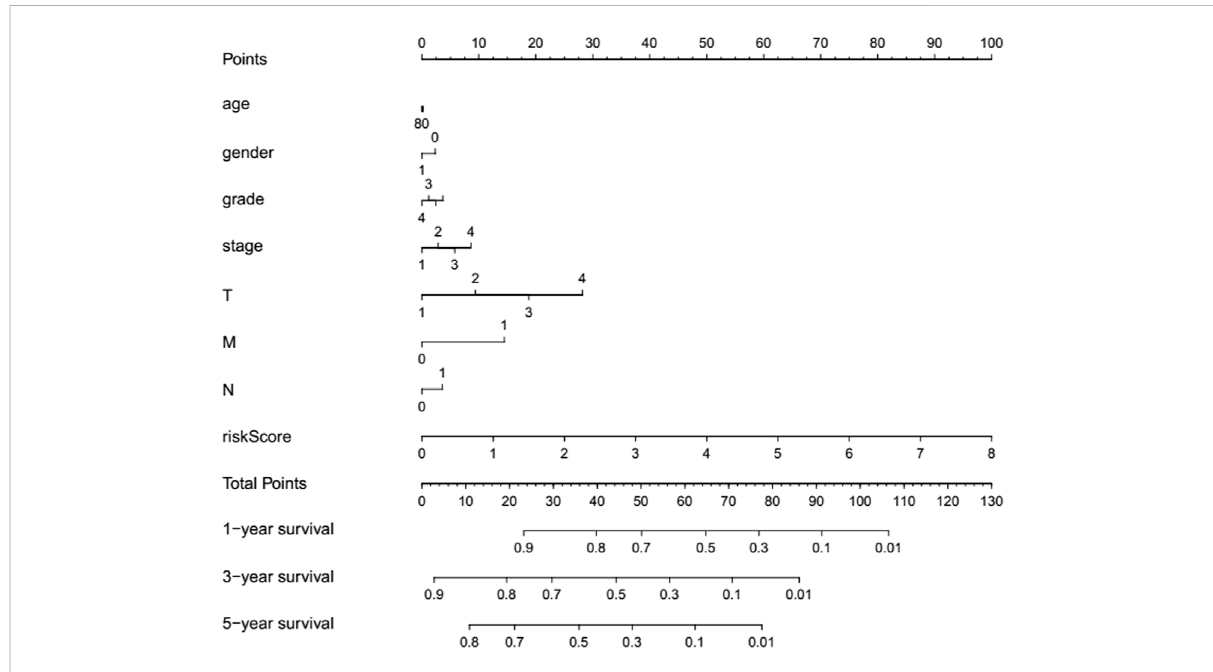
FIGURE 8 Prognostic nomogram established via the combination with the clinicopathologic features and risk